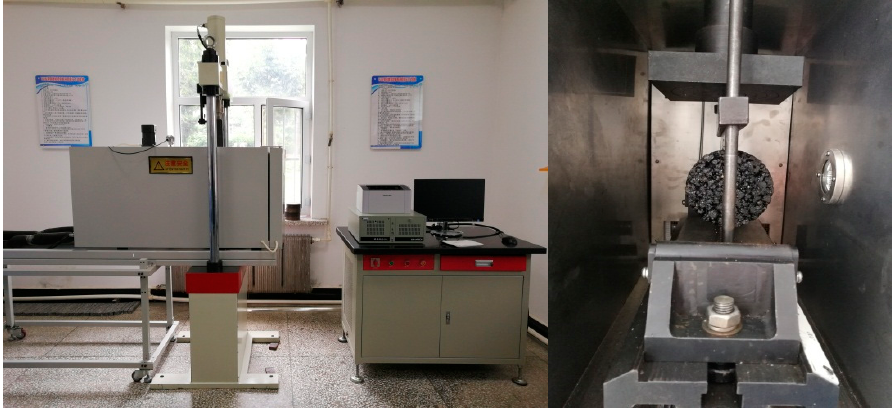
Figure 4. The low-temperature splitting Figure 4. The low ‐ temperature splitting test.